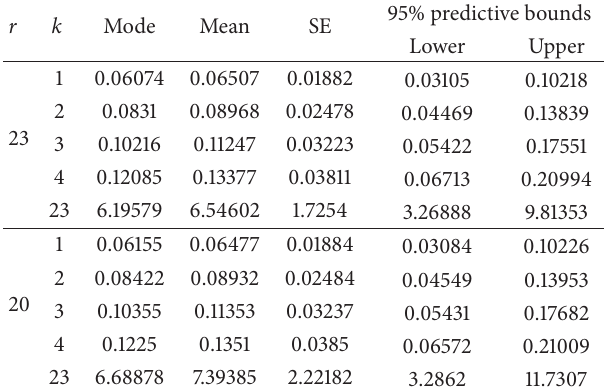
Table 11: The summary of the two sample predictive densities for real data